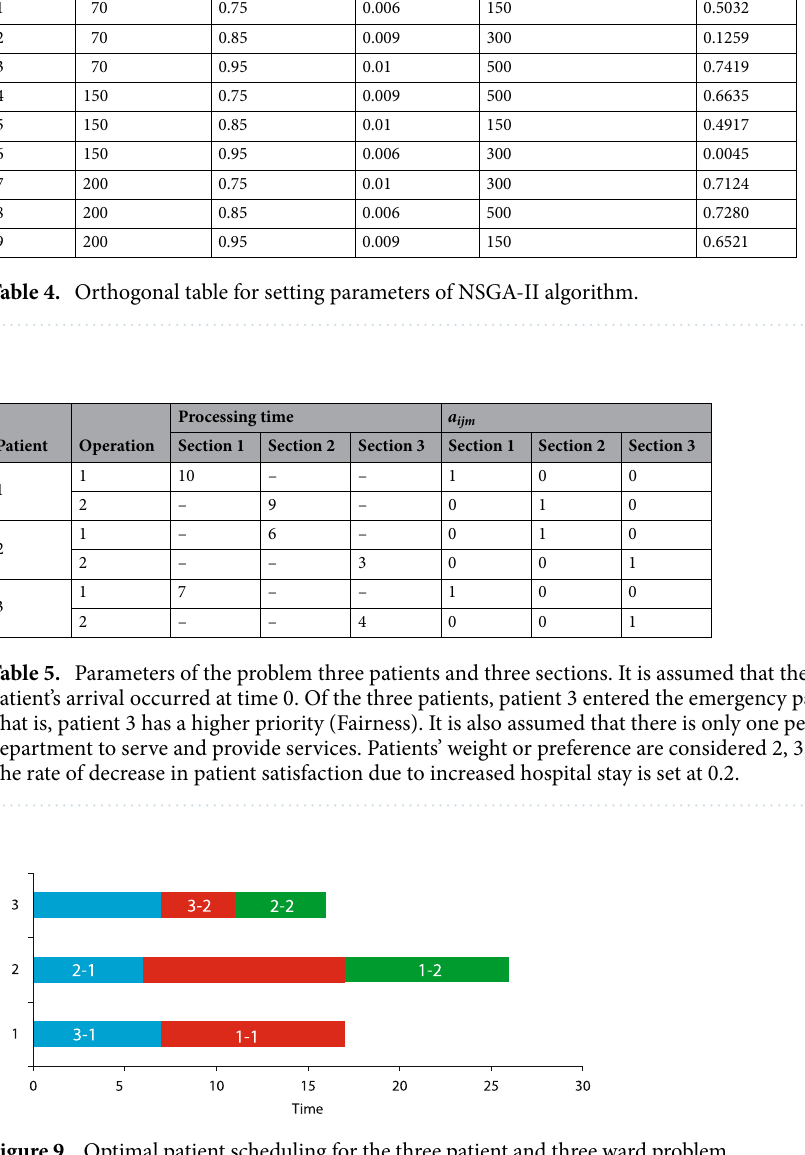
Figure 9. Optimal patient scheduling for the three patient and three ward problem.